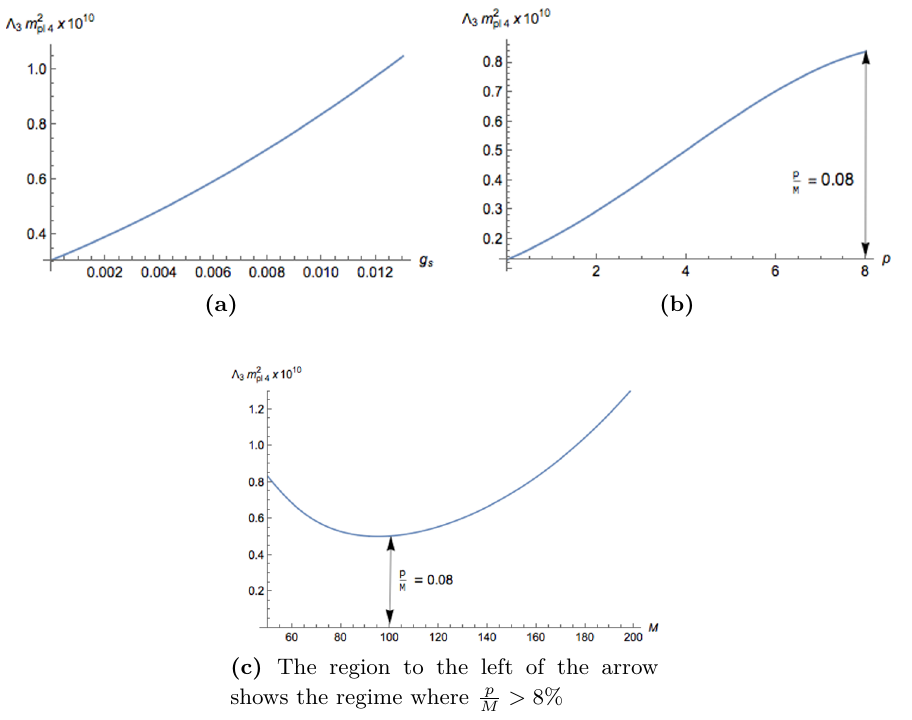
Figure 8. Plots showing how sensitive the cosmological constant is to change in certain